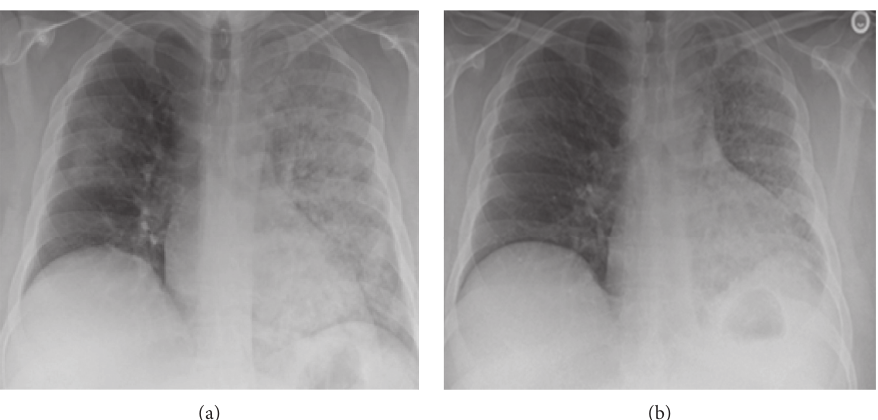
Figure 2: (a) Chest X-ray showing worsening left-sided infiltrates. (b) Chest X-ray showing mild improvement of left upper lobe consolidation.